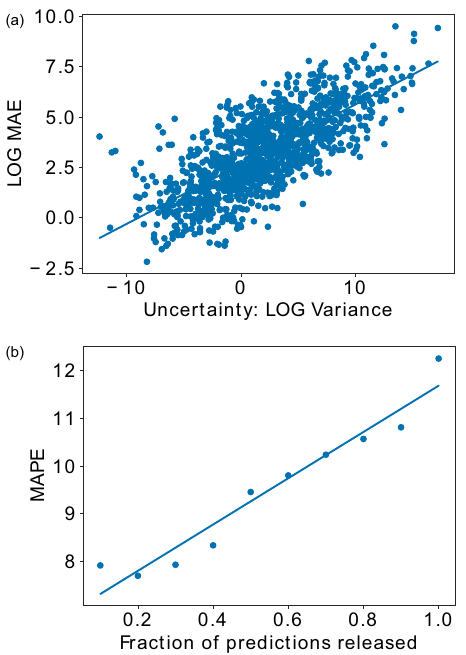
Fig. 4 Model uncertainty. a Model disagreement due to model uncertainty, measured as average prediction variance across the top k = 5 models, versus the MAE performance, both plotted in log space. From this, we see that higher model disagreement correlates with worse metric performance. For the best fi t line, R 2 = 0.539, 4.39 x + 3.37. b A rejection diagram showing the percentage of dates on which a prediction is made, after thresholding on model disagreement due to model uncertainty, versus the MAPE perfor- mance on those dates. From this, we can see that better average metric performance (on the days for which a forecast is released) can be achieved by withholding forecasts on days with higher model disagreement. Thus, we fi nd the reliability of the forecasting system can be improved through model uncertainty thresholding. For the best fi t line, R 2 = 0.941, f ( x ) = 2.18 x +